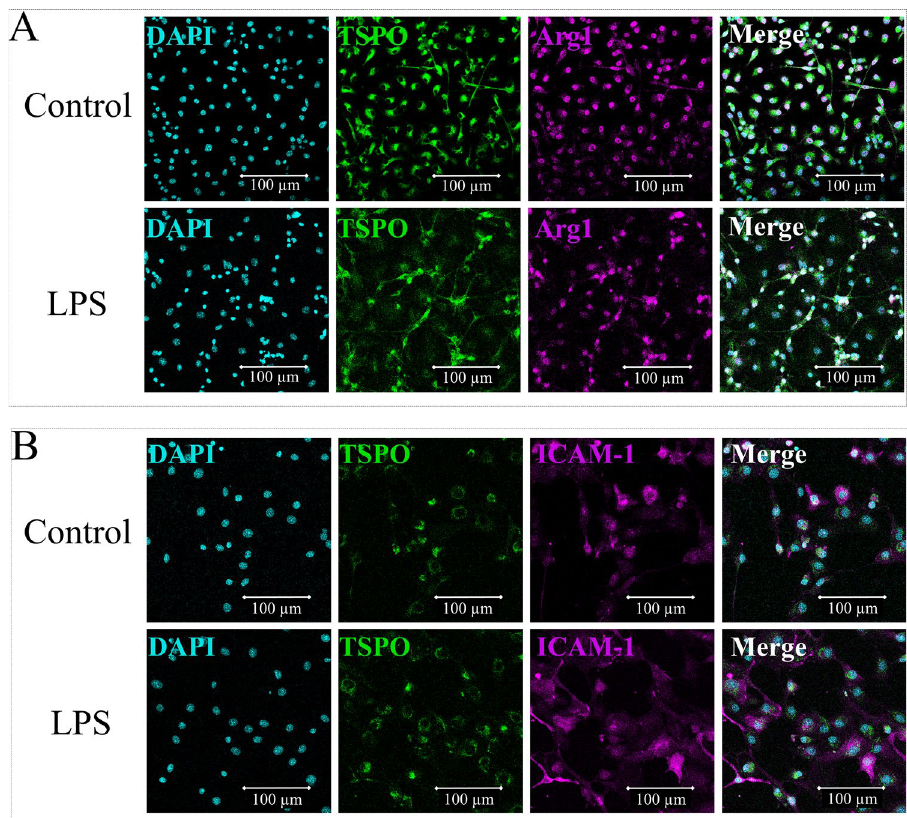
Figure 3. Immunocytochemistry on cell culture. ( A ) primary microglial cell culture with DAPI/Arg1/TSPO staining, treated with PBS (control condition) or LPS 100 ng/mL (LPS), at × 40 lens and ( B ) brain endothelial cell strain (bEnd3) with DAPI/TSPO/ICAM-1 staining, treated with PBS (control condition) or LPS 100 ng/mL (LPS) at × 40 lens. bEnd3 brain endothelial cell strain, LPS Lipopolysaccharide, PBS Phosphate Buffered Saline, TBI traumatic brain injury, TSPO translocator protein.